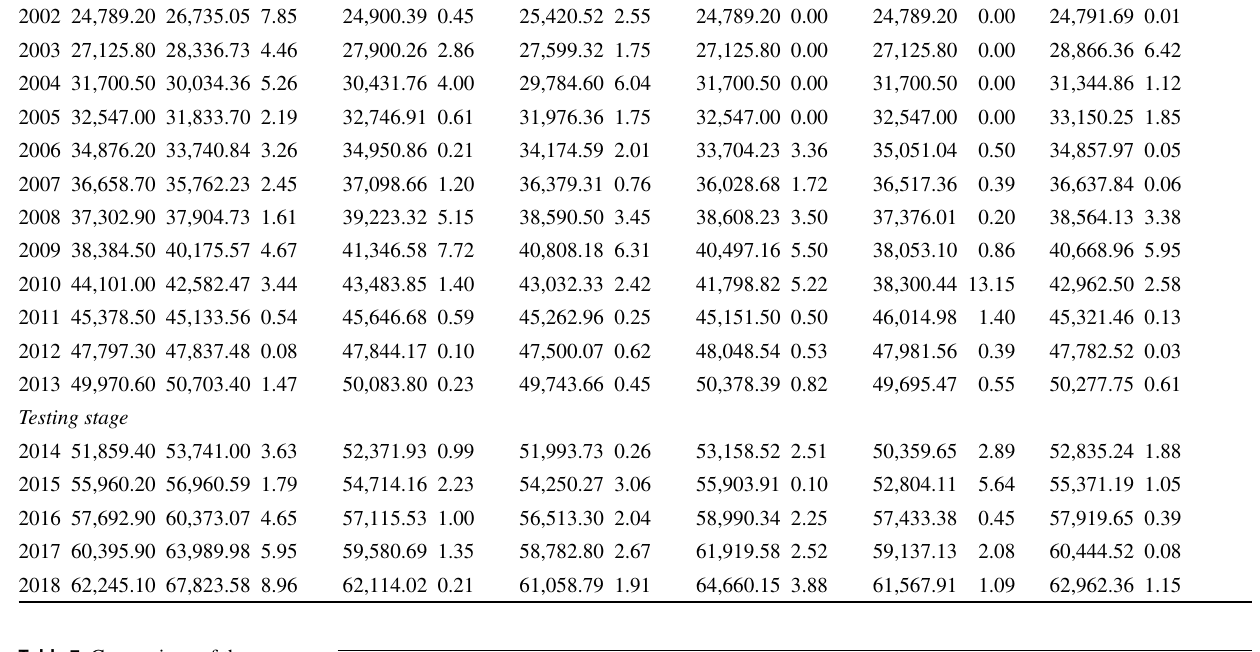
Table 7 Comparison of the prediction accuracies of the six models in China’s petroleum terminal